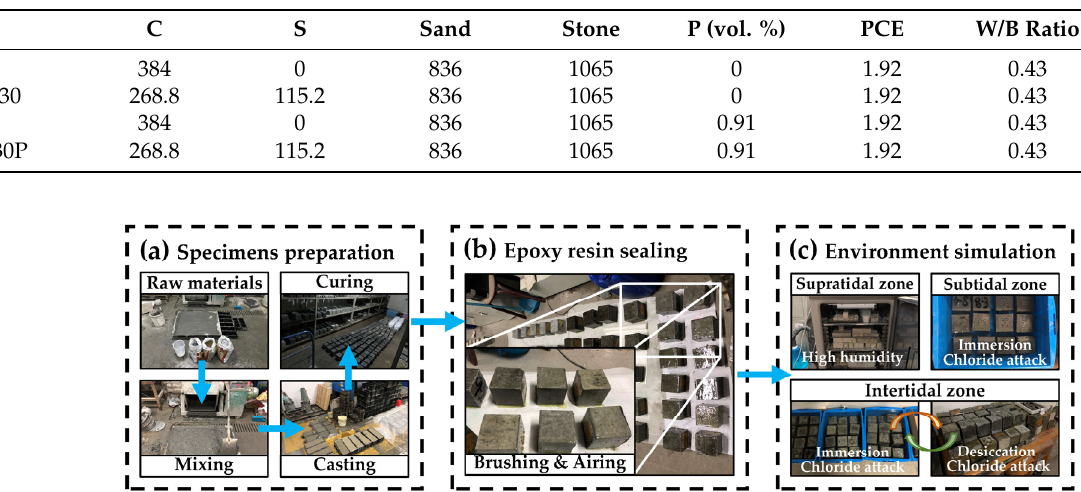
Table 4. The mix ratio of CBRM-Concrete (kg/m 3 ).